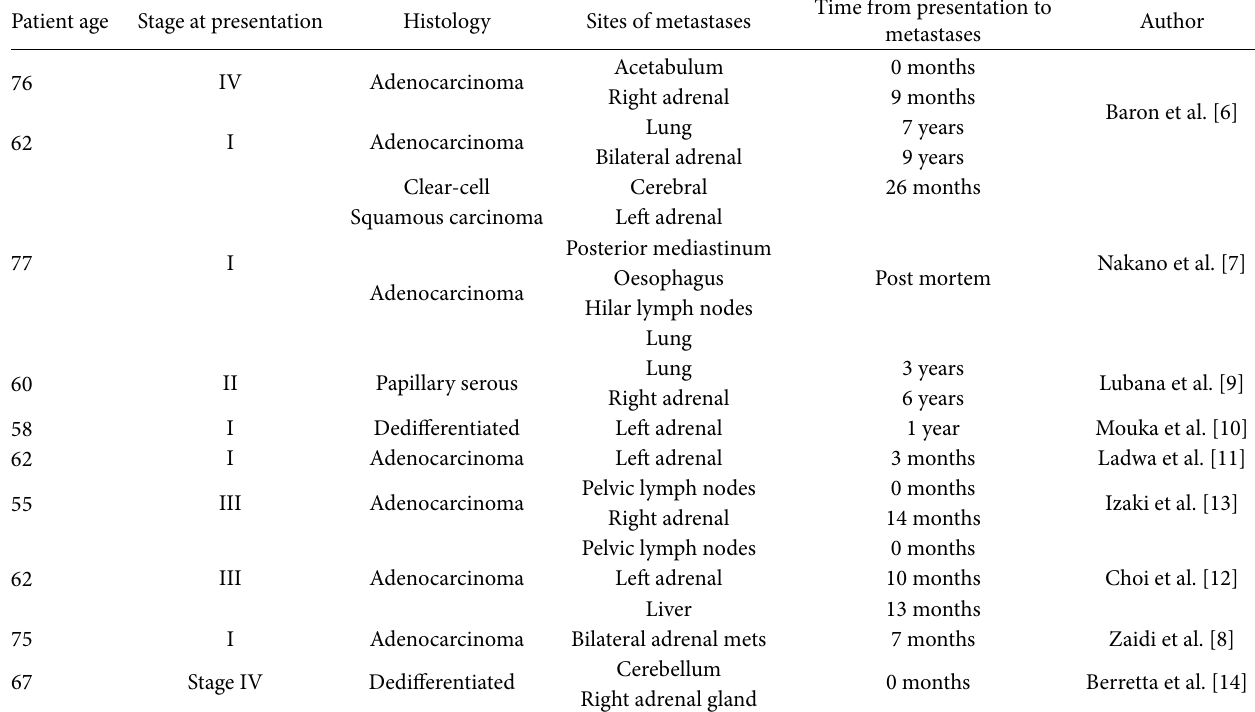
Table 1: Summary of case reports identified on literature